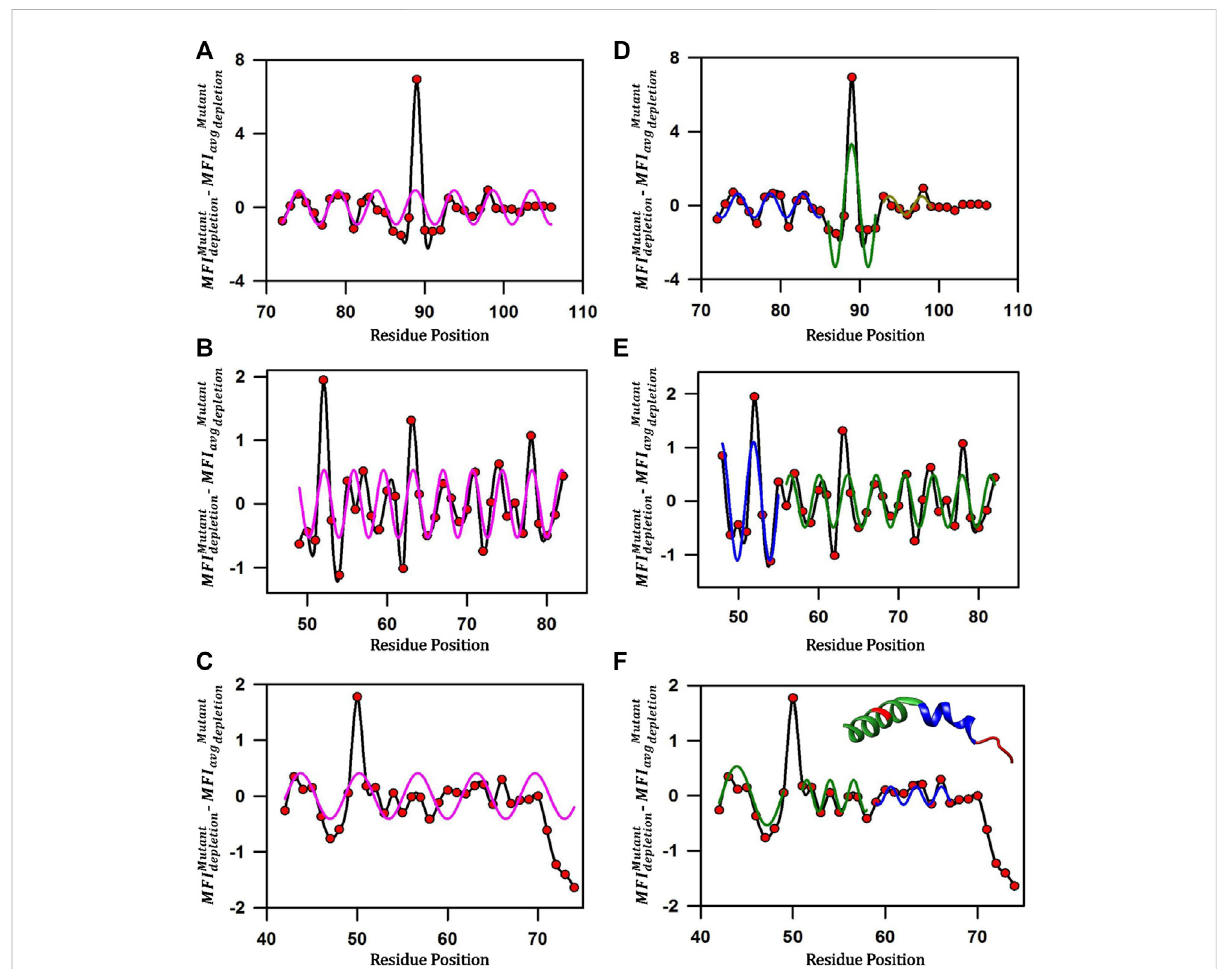
FIGURE 7 Predicting local structural features attained by disordered MazE antitoxins upon toxin binding. (A – C) Corrected mutational scores − MFI avgMutant ) of cysteine mutants (red circles) as a function of residue position plotted as a spline curve (black), reveals an oscillating ( MFI Mutant depletion depletion pattern in MazE antitoxin mutational effects. When a single sinusoidal curve (magenta) is fi t to the corrected mutational scores of residues 72 – 106, 48 – 82, 42 – 74 for MazE3, MazE6 and MazE9 respectively, the fi t is poor. The MFI avgMutant depletion is the MFI Mutant depletion of cysteine mutants averaged over sevenresiduewindows. (D – F) Thecorrectedmutationalscores fi ttoseparatesinusoidalcurves. (D) ( MFI Mutant depletion − MFI avgMutant depletion ) forresiduestretches 72 – 85, 86 – 92 and 93 – 99 of MazE3 fi t to three separate sinusoidal curves. The fi ts for the 72 – 85, 86 – 92 and 93 – 99 residue stretches are shown in blue, green and dark yellow lines respectively. Residue stretch 100 – 106 does not fi t to a sinusoidal curve. (E) For MazE6, the ( MFI Mutant depletion − MFI avgMutant depletion ) for residue stretches 48 – 55 and 56 – 82 are fi t to two separate sinusoidal waves. The fi ts for 48 – 55 and 56 – 82 residue stretches are showninblueandgreenlinesrespectively.(F) ( MFI Mutant depletion − MFI avgMutant depletion ) forresiduestretches42 – 58(excludingresidue50)and59 – 67ofMazE9 fi t totwoseparatesinusoidalwaves.The fi tsfor42 – 58and59 – 67residuestretchesareshowningreenandbluelinesrespectively.Thefourthstretchof residues 68 – 74 does not fi t well to sinusoidal wave. Residue 50 was an outlier and excluded from the fi t. In the inset, the MazE9 antitoxin (residues 42 – 72) from the MazEF9 crystal structure (PDB ID: 6KYT) is shown, with the residue stretches coloured identically to the colours of the fi t. Residues 50and68 – 74arecolouredred.ThehelicalregionsinferredfromthemutationaldataforMazE9agreewellwiththosefromthecrystalstructure. The troughs and valleys in the plots correspond to the interacting and non-interacting residues respectively. Both the inferred secondary structure and sites for interaction inferred from the DMS data agree well with the crystal structure. In contrast, PSIPRED (Jones, 1999) predicts helical stretches from residues 39 – 50, 57 – 83 and 91 – 100 in MazE3, residues 9 – 22, 26 – 56 and 61 – 77 in MazE6 and residues 9 – 21, 27 – 39, 43 – 56 and 65 – 66 in MazE9